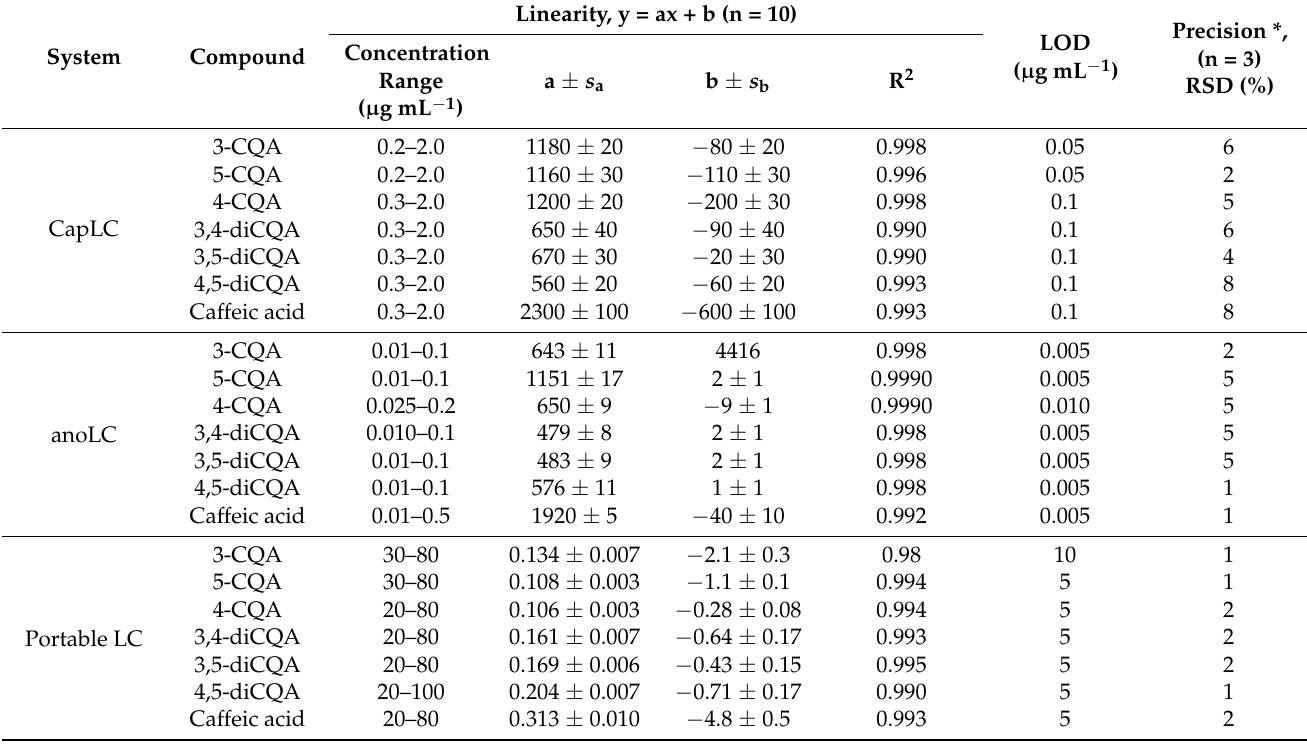
Table 1. Analytical parameters of the three tested